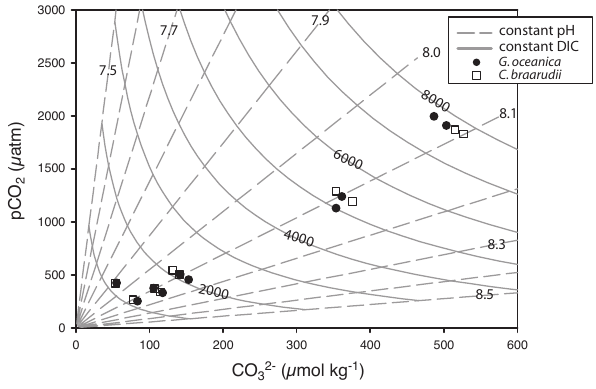
CO 32- (µmol kg -1 ) Fig. 1. The carbonate chemistry conditions (CO 2 − in µmol/kg 3 and p CO 2 in µ atm) as measured at the beginning of each of our incubations for G. oceanica (black dots) and C. braarudii (open squares). Contours of constant pH with increasing DIC are indi- cated by the dashed grey lines whereby saturation state (propor- tional to CO 2 − since all experiments were run at constant Ca con- 3 centration of 10mmol/kg) and p CO 2 are positively correlated in our experiments. By contrast, the majority of previous experiments follow the solid grey curves at constant DIC but with varying pH which results in an inverse correlation between p CO 2 and satura- tion